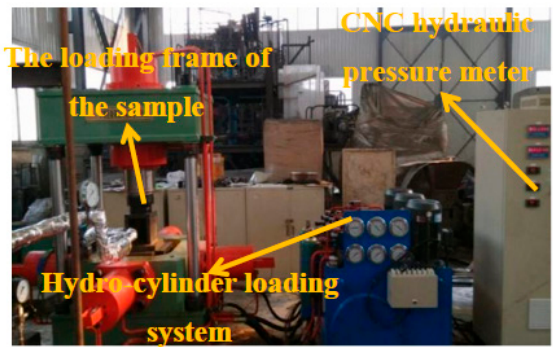
Figure 3. Large-size true three-axes press.